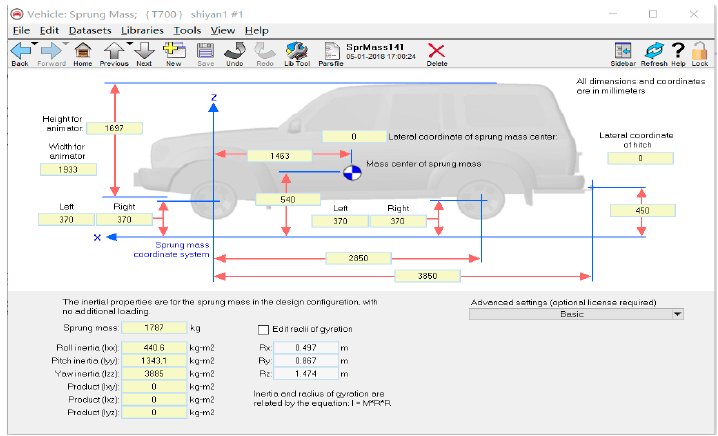
Figure 11. Model Vehicle Parameter Setting.